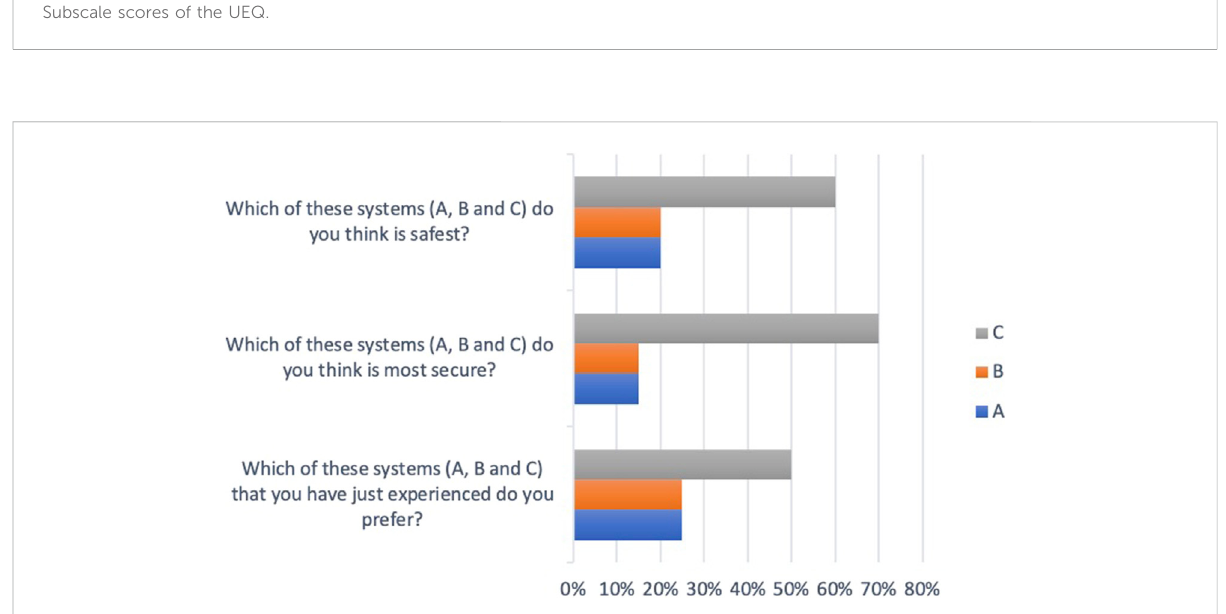
FIGURE 21 Perceived safety, security, and preference of the three HMI